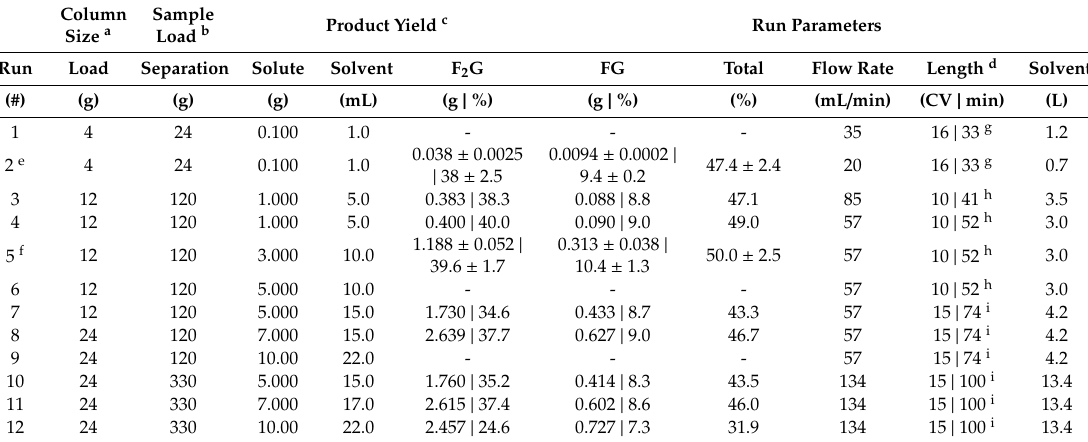
Table 2. Flash chromatography parameters and separation results for the purification of F 2 G and FG. Column Size